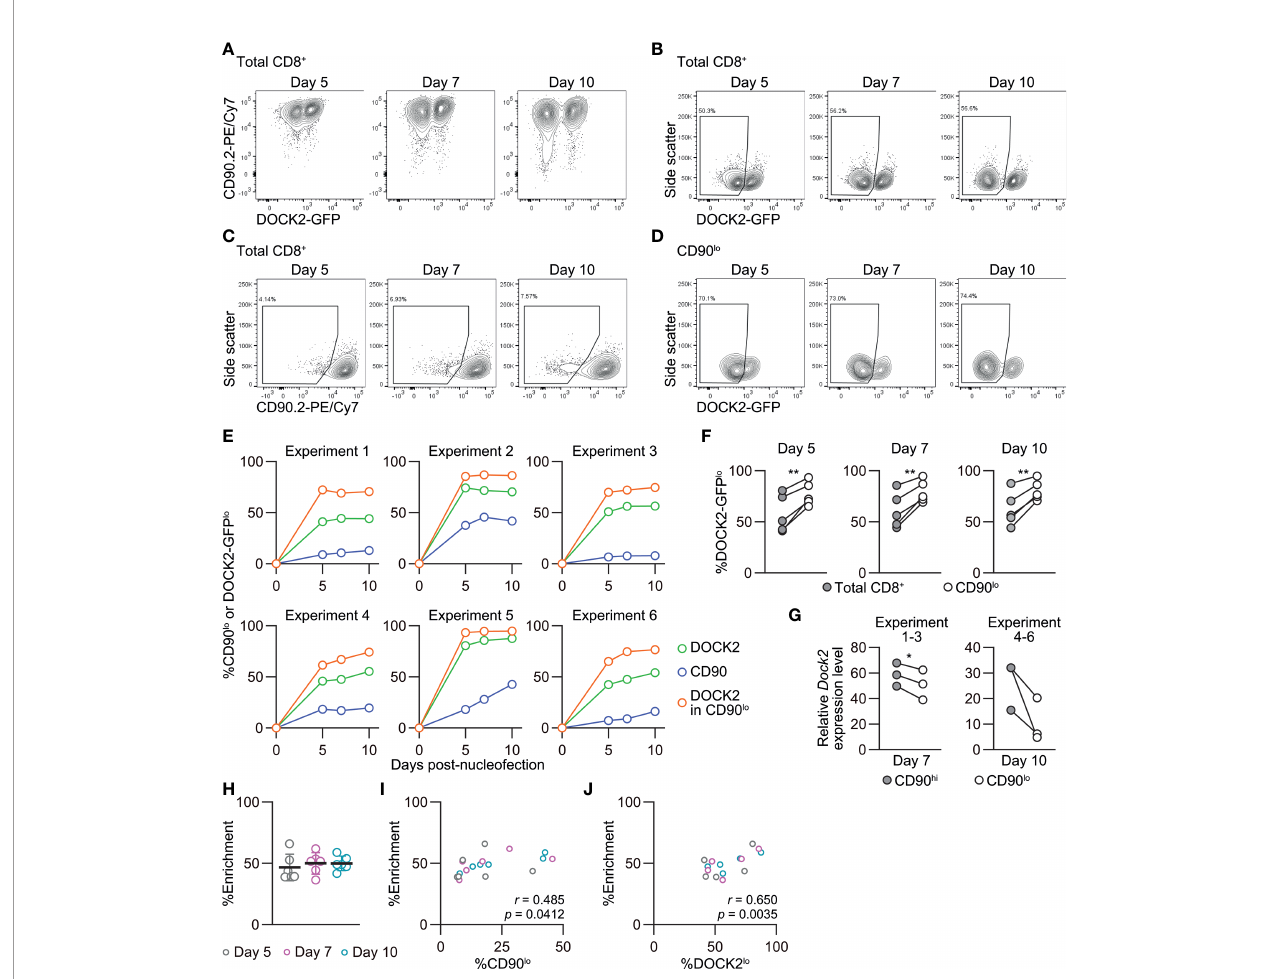
FIGURE 7 | Enrichment of DOCK2-knockout cells using simultaneously targeted CD90 as a reporter in naïve CD8 + T cells. DOCK2-GFP CD8 + T cells were nucleofected with CD90 and/or DOCK2 crRNAs using P4/DS137. (A – D) Representative fl ow cytometric plots of DOCK2-GFP versus CD90 (A) , DOCK2-GFP (B) and CD90 (C) among total CD8 + T cells and DOCK2-GFP among CD90 lo cells (D) . Plots are taken from experiment 3. (E) %CD90 lo cells among total CD8 + T cells and %DOCK2-GFP lo cells among total and CD90 lo CD8 + T cells. (F) Paired comparison of %DOCK2-GFP lo cells between total and CD90 lo CD8 + T cells in six independent experiments. ** p < 0.005 by paired t -test. (G) Dock2 mRNA level in sorted CD90 lo and CD90 hi CD8 + T cells. Data are normalized to the expression level of Dock2 in the control cells that are nucleofected only with three CD90 crRNAs. Cells were sorted on day 7 or 10 for experiments 1 – 3 or 4 – 6, respectively. * p < 0.05 by paired t -test. (H) Enrichment ef fi cacy of DOCK2-GFP lo cells by gating on CD90 lo cells on each time point measured with %enrichment values. No statistically signi fi cant difference by Kruskal-Wallis test with Dunn ’ s post-hoc . (I, J) Correlation between %enrichment and the frequency of CD90 lo (I) or DOCK2-GFP lo cells (J) among total viable CD8 + T cells. Pearson correlation coef fi cient was computed using the pooled data of six independent